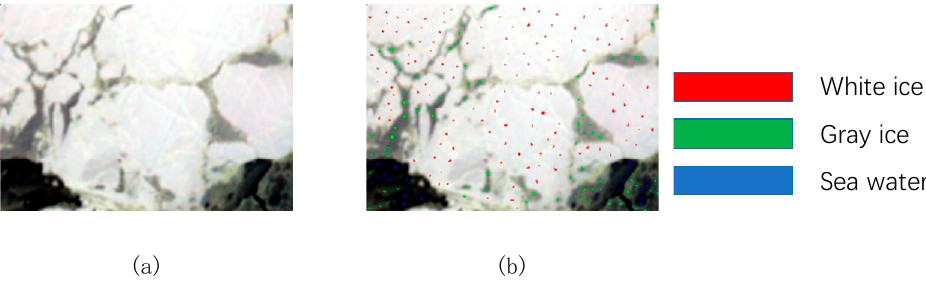
Figure 5. ( a ) False-color images with delineation of the experimental area (R: 175, G: 168, B: 150); ( b ) ground truth. Table 6. Number of training samples (pixels) and testing samples (pixels) in each class for the Baffin Bay data set.